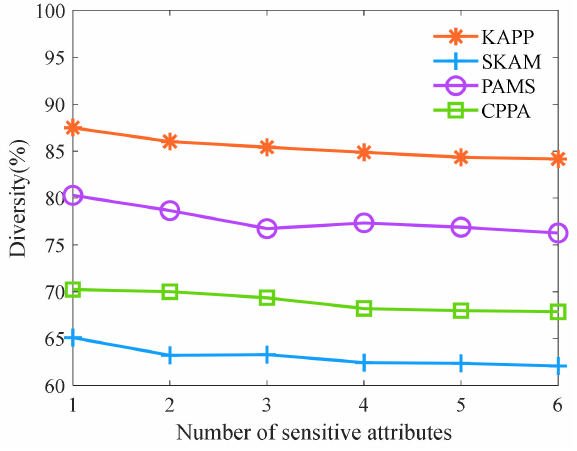
Figure 9. Diversity of the different numbers of sensitive attributes.